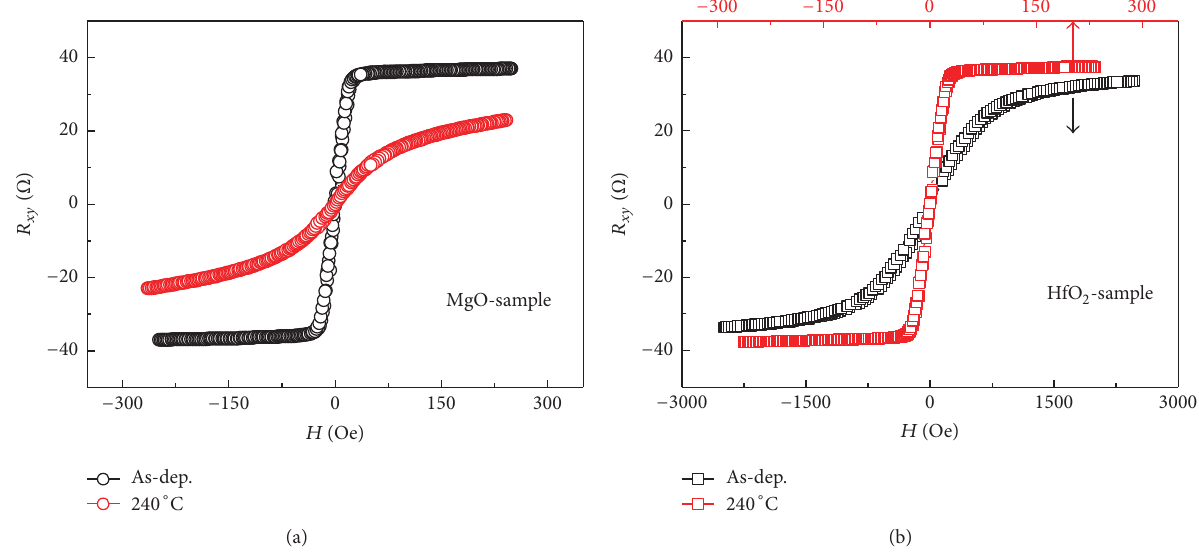
Figure 3: (a) 𝑅 𝑥𝑦 - H curves for sample Ta(0.8)/Co 20 Fe 80 (0.8)/MgO(0.8)/Ta(1.0) (in nm) in the as-deposited and 240 ∘ C annealed states. (b) 𝑅 𝑥𝑦 - H curves for sample Ta(0.8)/Co 20 Fe 80 (0.8)/HfO 2 (0.8)/Ta(1.0) (in nm) in the as-deposited and 240